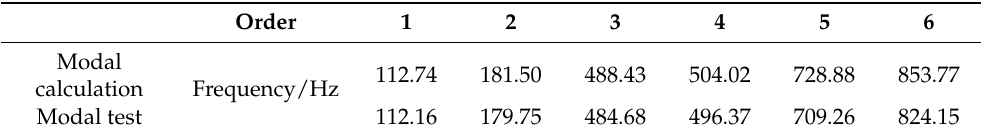
Figure 3. The modal shapes of the resonant system calculated by FEA. ( a ) 1st order, ( b ) 2nd order, ( c ) 3rd order, ( d ) 4th order, ( e ) 5th order, ( f ) 6th order. Table 3. Modal results of the resonant system.